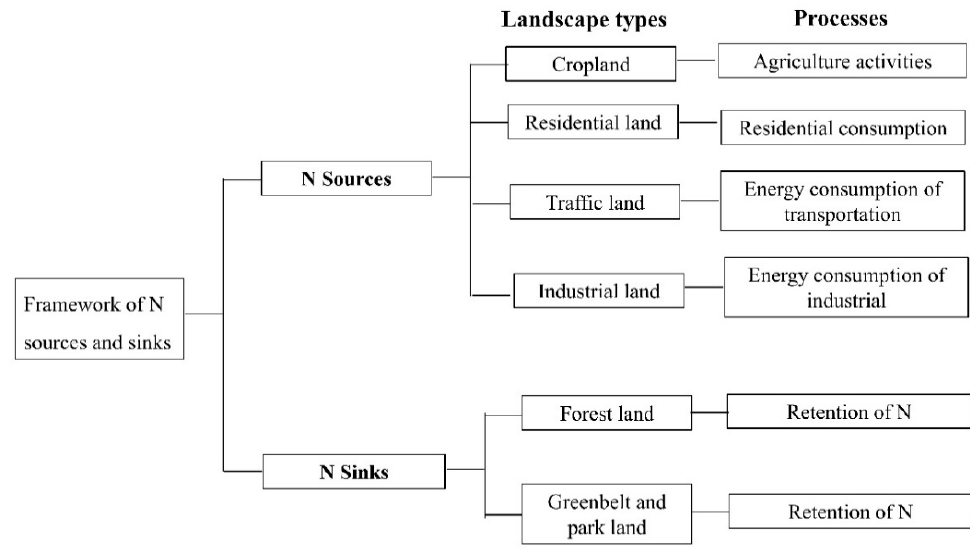
Figure 3. Accounting framework for N sources and sinks.